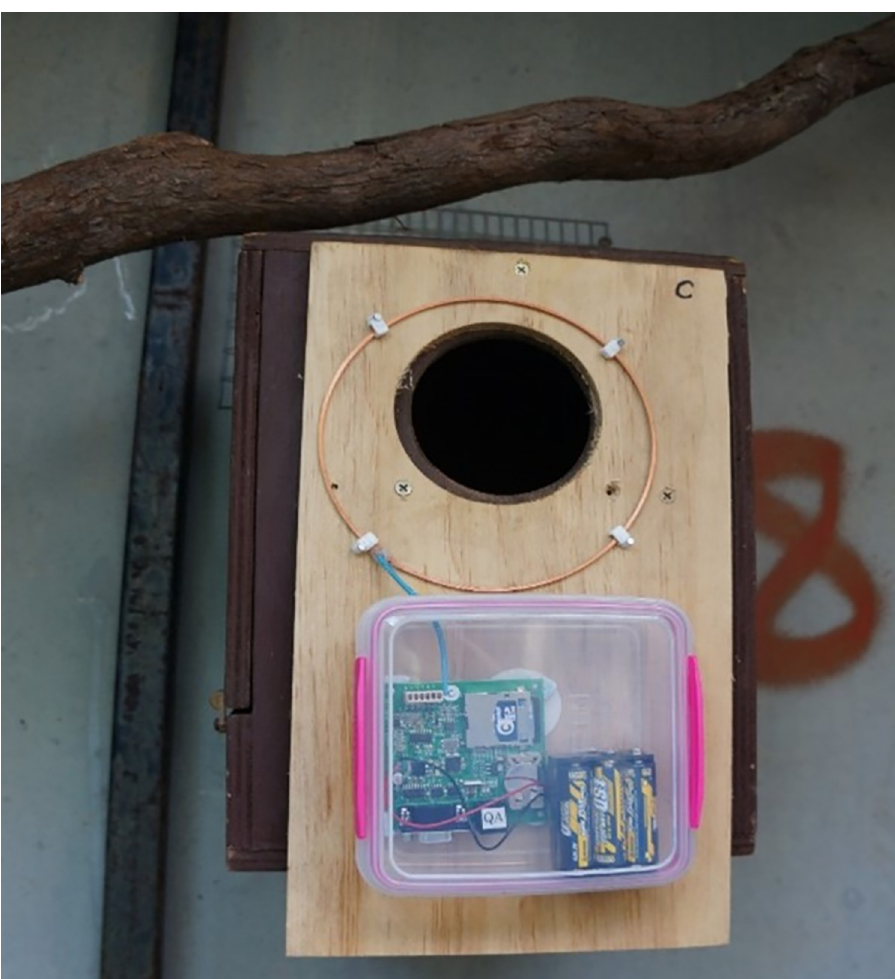
Fig 2. RFID logger (inside weather-proof housing) attached to a nestbox for Northern quolls with the RFID antenna placed around the entrance. Quenda study. The second application of our RFID loggers was on a wild population of quenda, a small omnivorous marsupial, residing in Craigie Bushland in Perth, Western Aus- tralia (-31.792772, 115.778711). Here, the RFID loggers were used to record the time of approach, foraging effort and individual identity of bandicoots at each feeding station. For this study, the antenna of the RFID logger was fixed around the entrance to a feeding station (a 90˚ PVC storm pipe elbow or straight length of PVC, with a food reward buried at the bottom) (Fig 3), which encourages the animal to pass through the antenna, giving the best probability of detection. Each RFID logger was monitored by a camera trap to validate the data captured by the RFID loggers. Camera traps alone were not sufficient for this study as quenda cannot be individually identified from images. We deployed 5 RFID loggers over 4 nights. From these data, we determined the latency to approach (time of first entry), foraging effort (length of time between first and last entry read) and percentage of quenda successfully identified (vali- dated with camera-trap images). Within individual repeatability of latency to approach and foraging effort was calculated using a linear mixed model repeatability estimate with a restricted maximum likelihood function in the program R [27] using the package rptR [28].